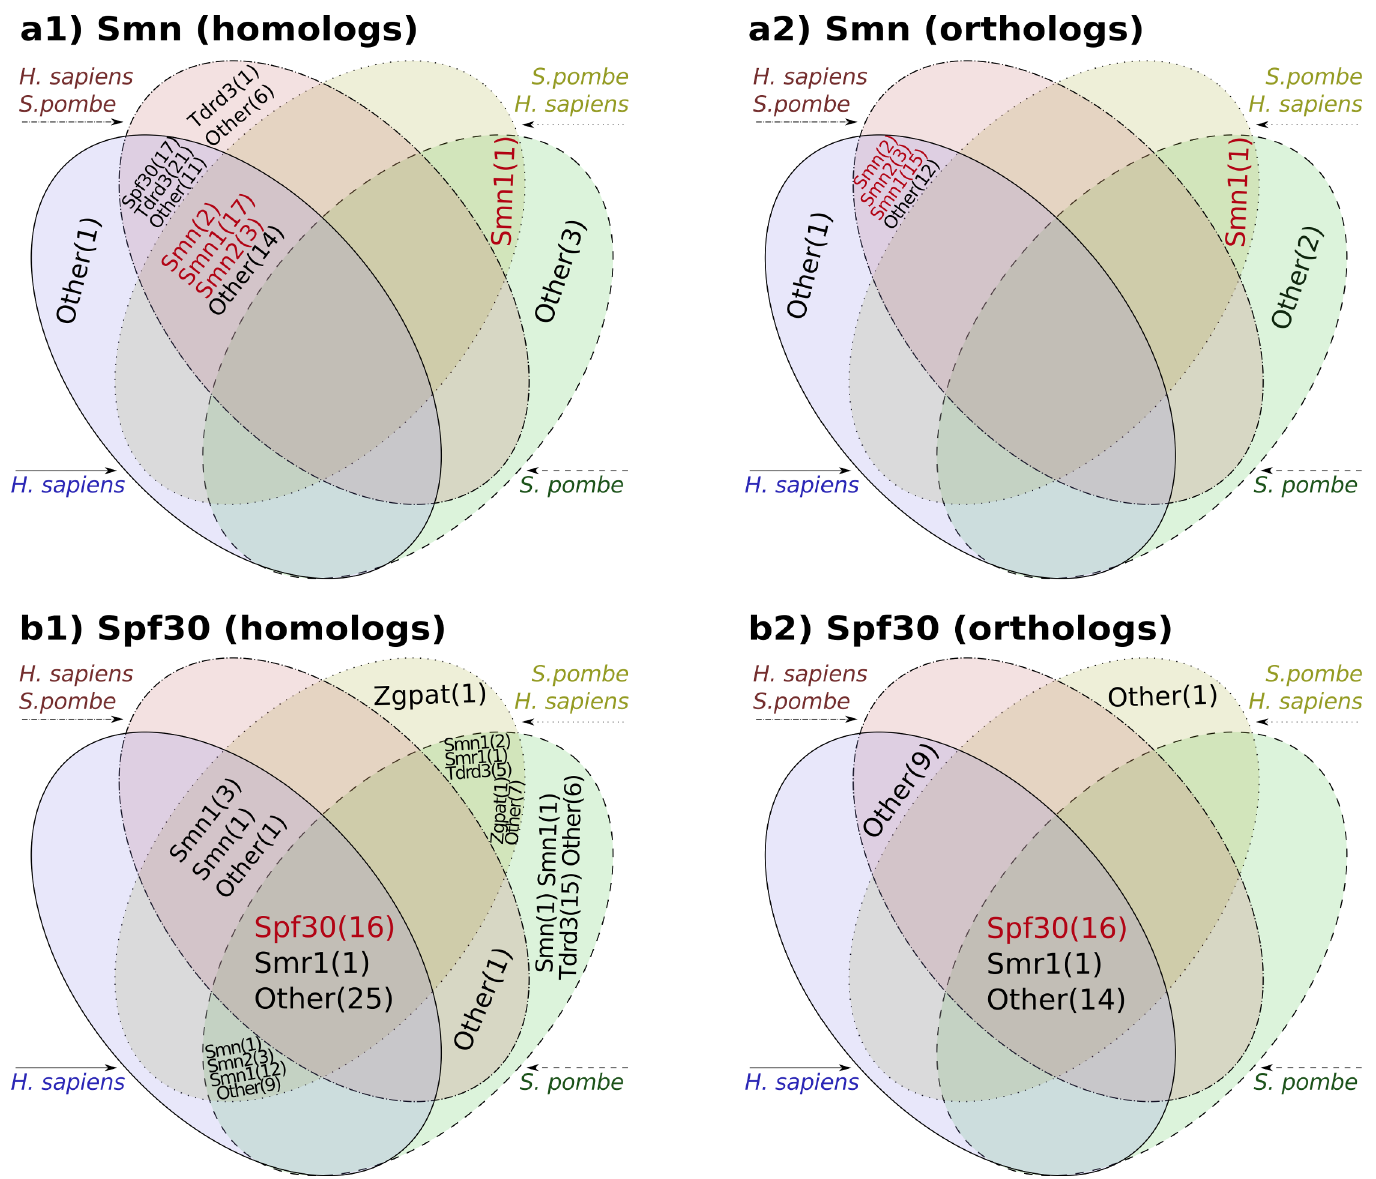
Fig 4. Gene names obtained when finding homologs and orthologs to Smn (a1 and a2, respectively) and Spf30 (b1 and b2, respectively) proteins using orthoFind and different query sequences. Four executions were made for each group using either one of the following query sequences: H . sapiens , S . pombe , H . sapiens plus S . pombe (using H . sapiens as reference for the alignments), or S . pombe plus H . sapiens (using S . pombe as reference for the alignments). Matching genes between the different executions are represented by the Venn diagrams, including the gene names and their number of occurrences (within parentheses). Gene names matching with the query name are highlighted in red color. Other = Uncharacterized